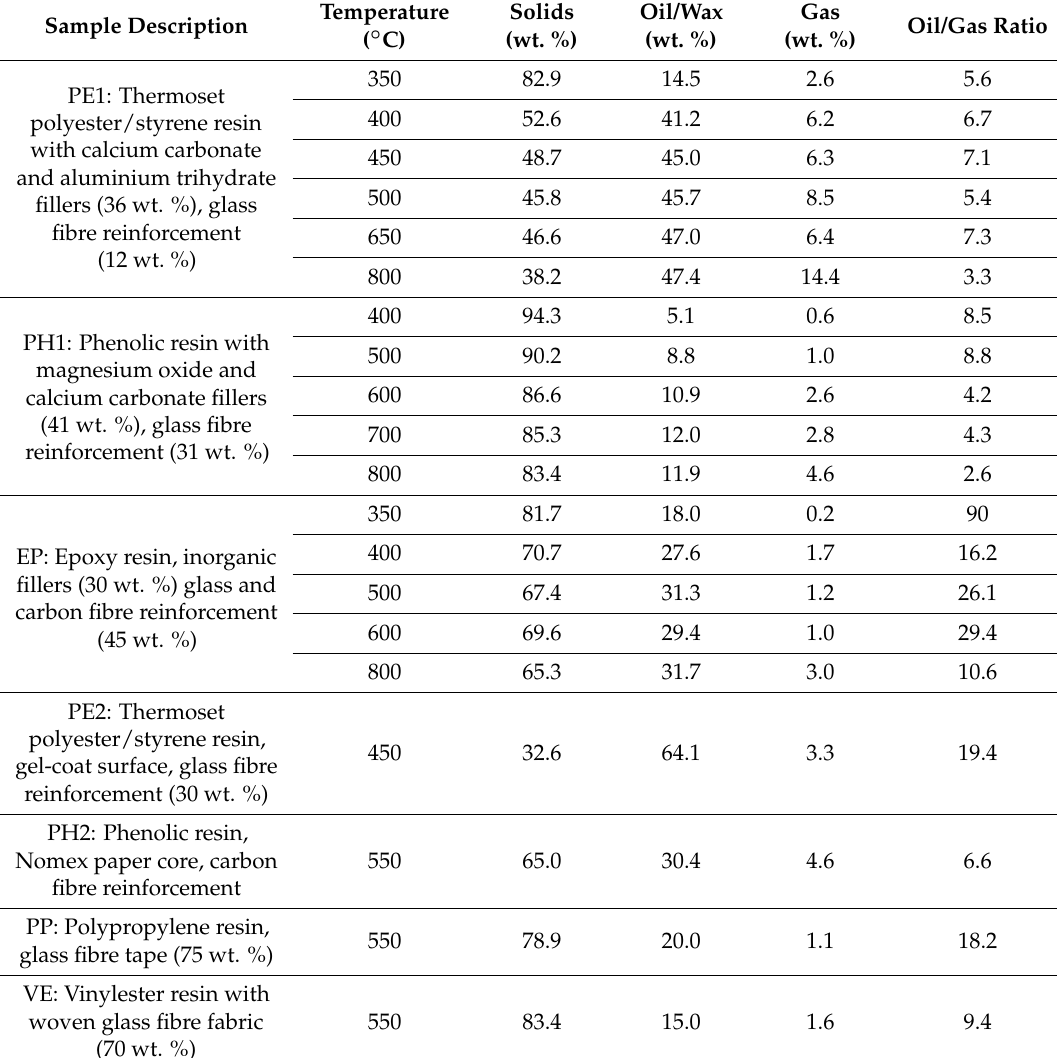
Table 6. Product yields from the pyrolysis of composites [26].